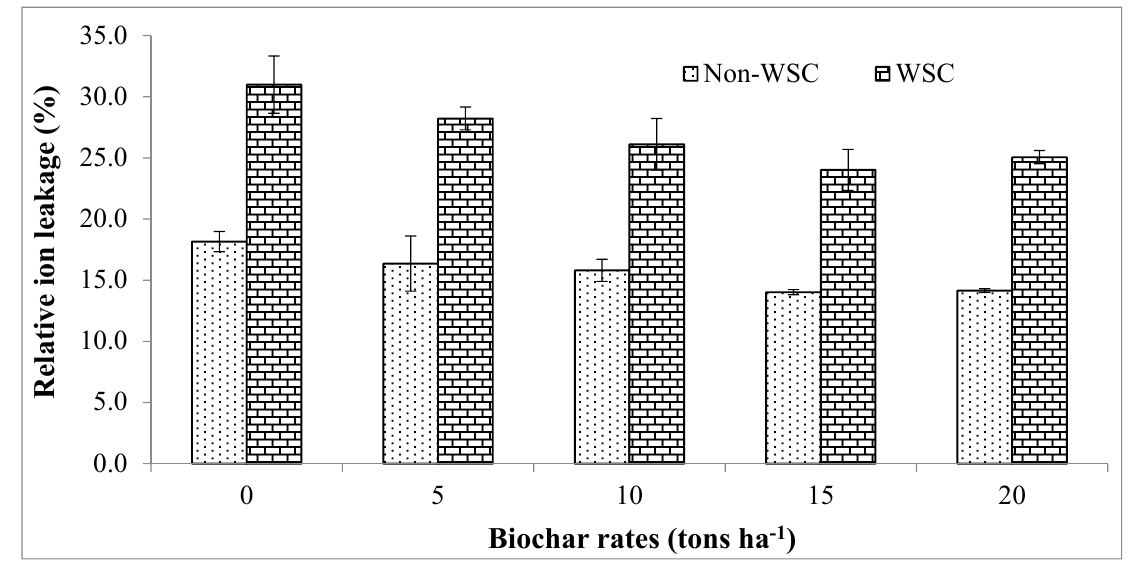
Figure 5. Effect of biochar on relative ion leakage of Ehretia asperula after 10 days without irrigation. Vertical bars represent the mean ± SD, n = 9.